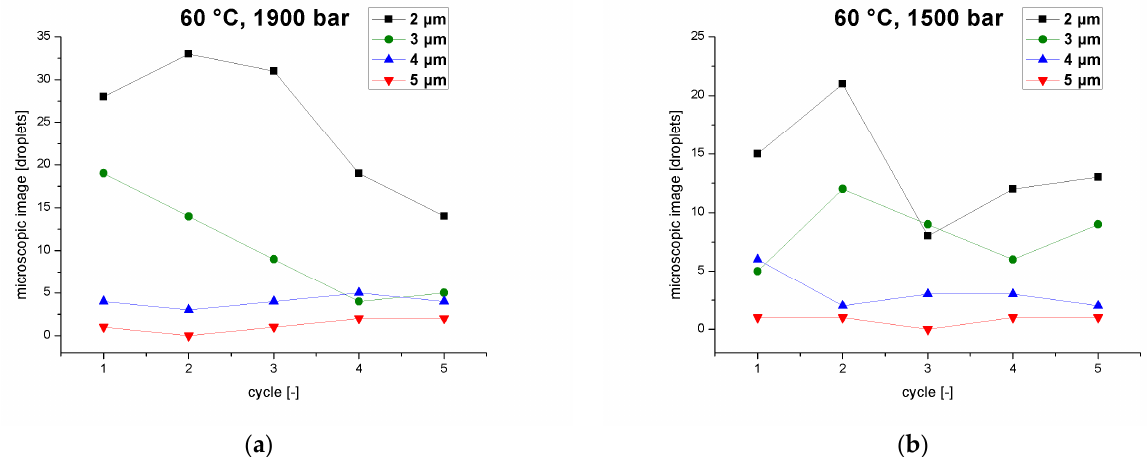
Figure 6. Droplet count of different particle size classes (2–5 µm)in an emulsion as a function of the number of cycles when the inlet temperature of the homogenizer is 60°C, at operating pressures of ( a ) 1900 bar, and ( b ) 1500 bar.